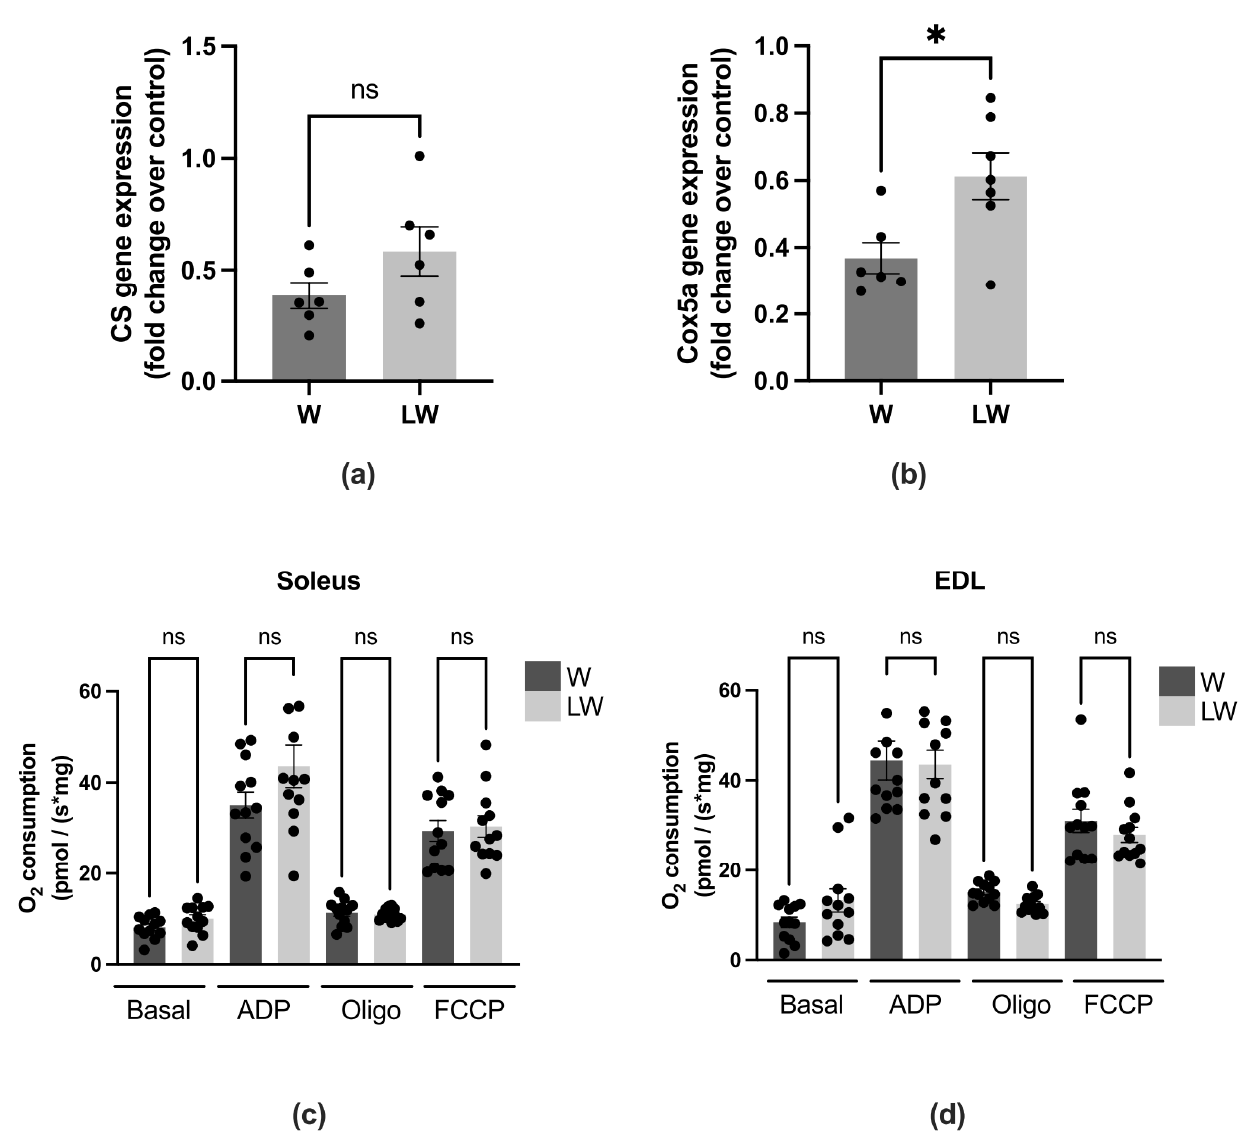
Figure 7. Muscular gene and protein expression among the different experimental groups. ( a ) Gene expression of citrate synthase and ( b ) (CS) cyclooxygenase (COX)5a. O 2 consumption ( ρ mol O 2 /s. mg tissue) compiled from the respiration traces comparing the ( c ) soleus and ( d ) EDL muscles biopsies from both tumour-bearing rats (W vs. LW group). For details, see the Methods section. For gene expression N = 6 and for oxygen consumption N = 10–12, at least ten independent experiments. Graphics represent mean ± SEM. * p < 0.05 and ns = not significant by ANOVA followed by t -test.